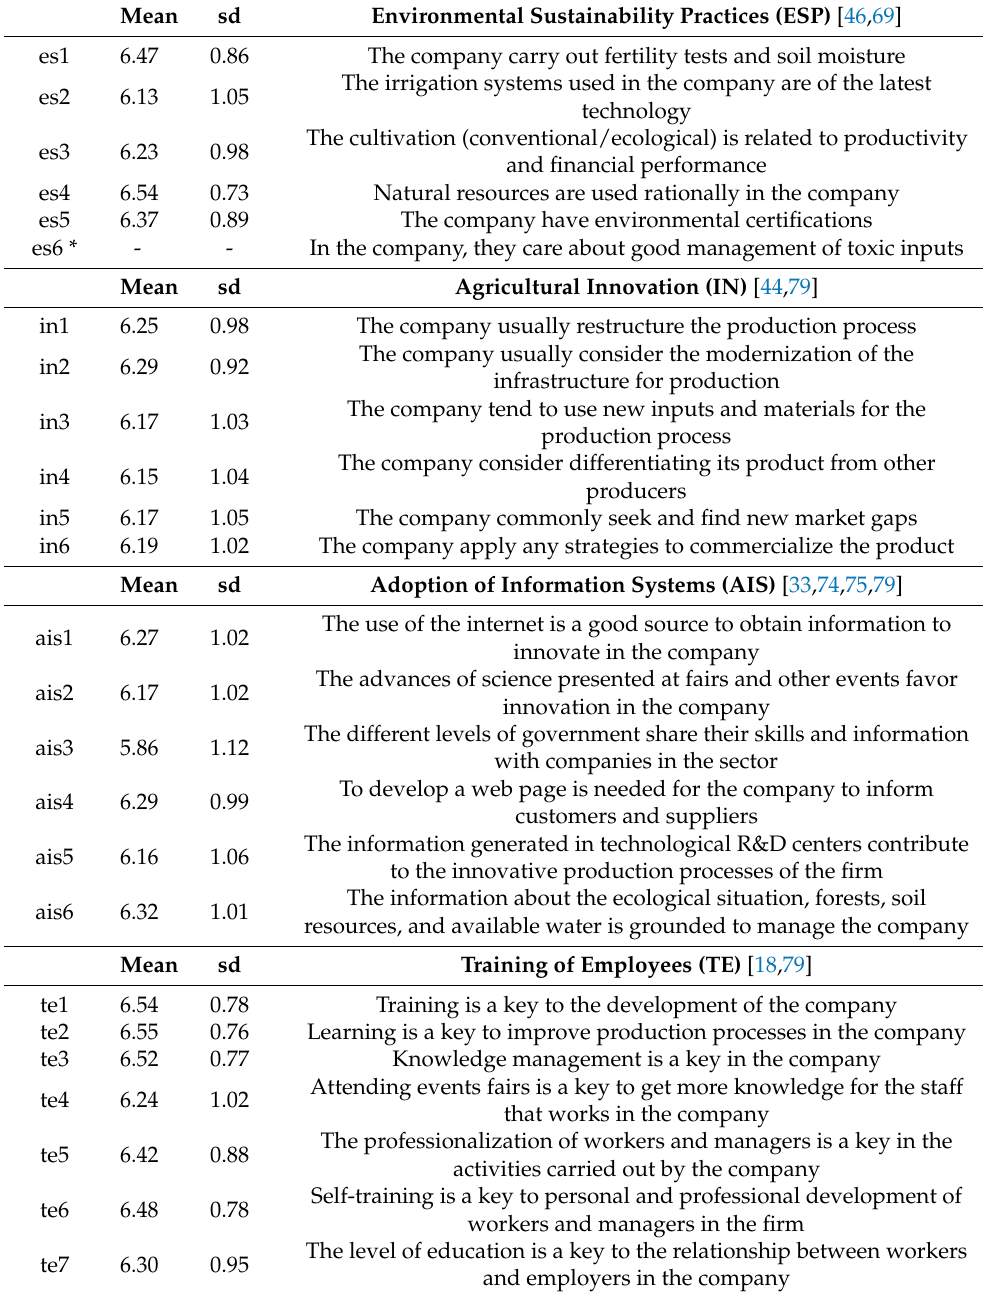
Table 2. Variable’s definition and descriptive